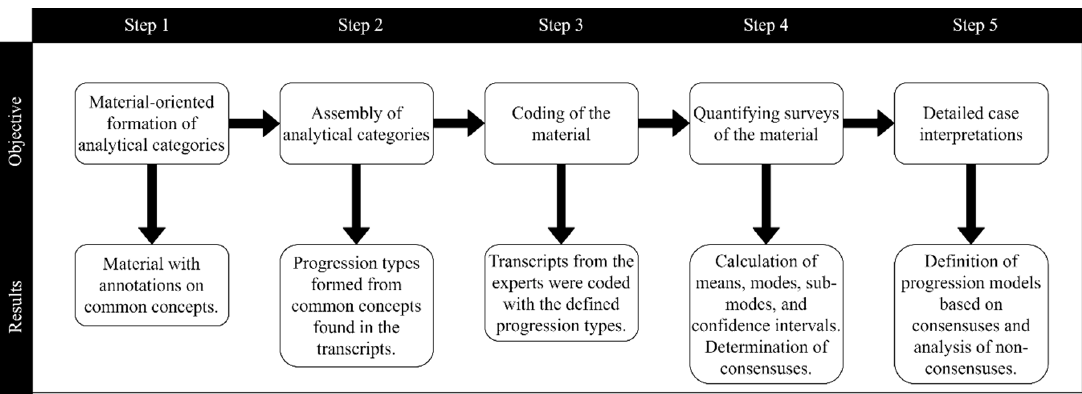
Figure 2. Quantitative analysis decision tree.